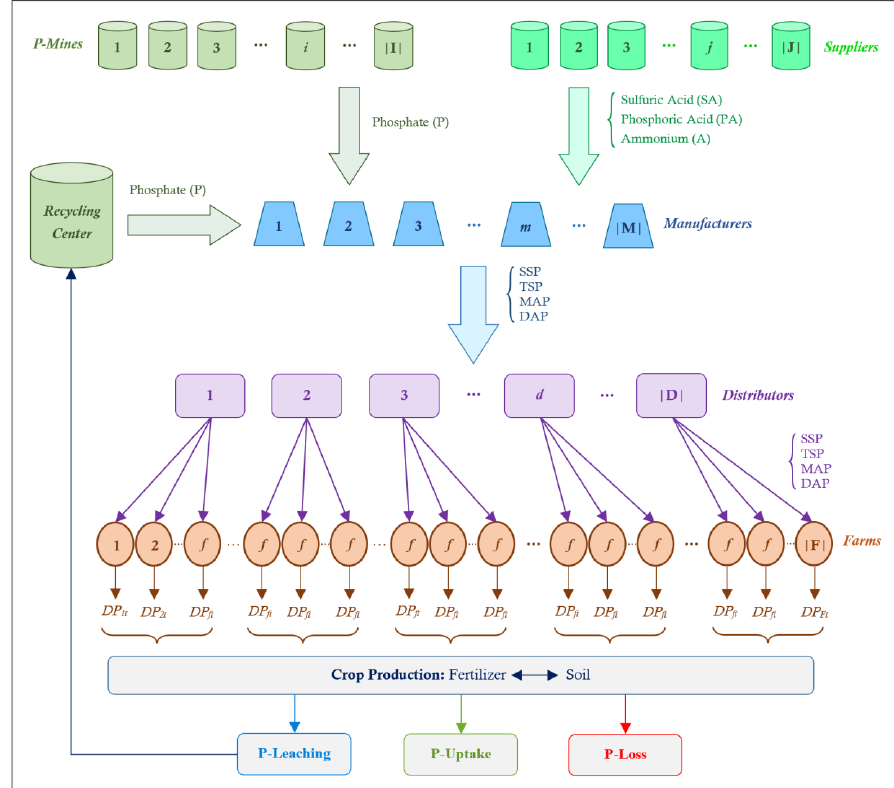
Figure 1. The PFSCM model.